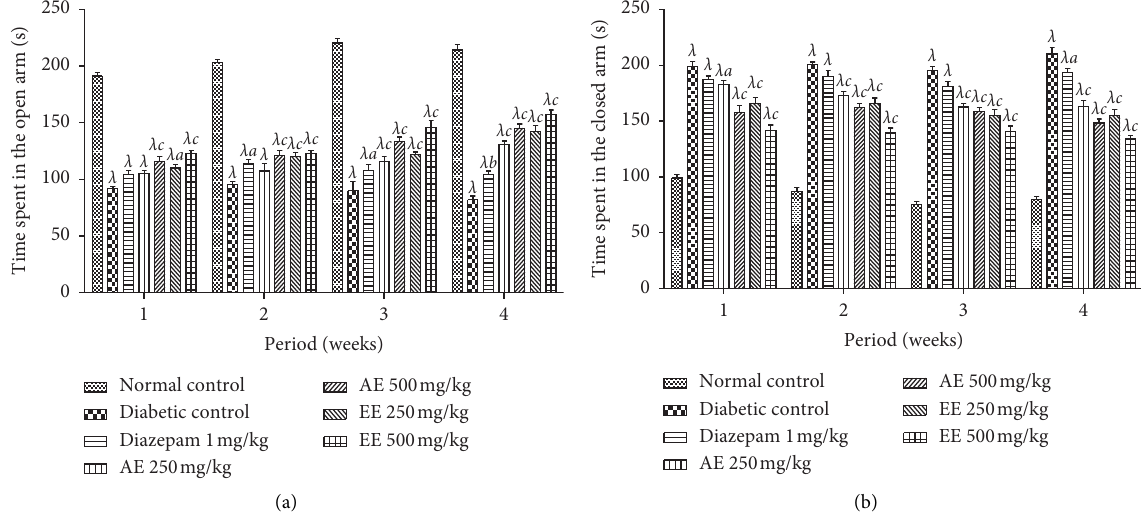
Figure 8: Effects of the aqueous (AE) and ethanol (EE) extracts of Dissotis thollonii on the absolute time spent in the open arms (a) and close arms (b) during 6min of exposure to the elevated plus maze. Values are expressed as mean ± SEM for six animals and analyzed by two-way ANOVA followed by Bonferroni post hoc test. λ p < 0 . 001 when compared with the normal control and a p < 0 . 05, b p < 0 . 01, c p < 0 . 001 when compared with the diabetic control; s: